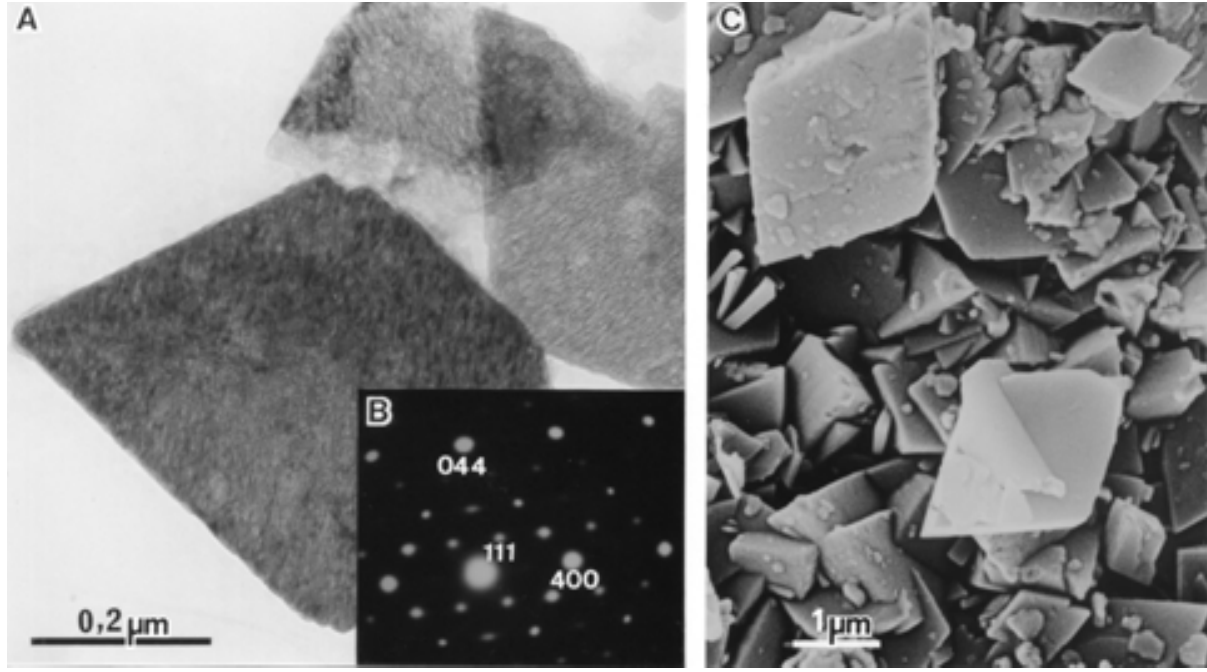
Figure 5. gamma-Al 2 0 3 (A) - transmission electron micrograph; (B) - selected area electron diffraction pattern; (C) scanning electron